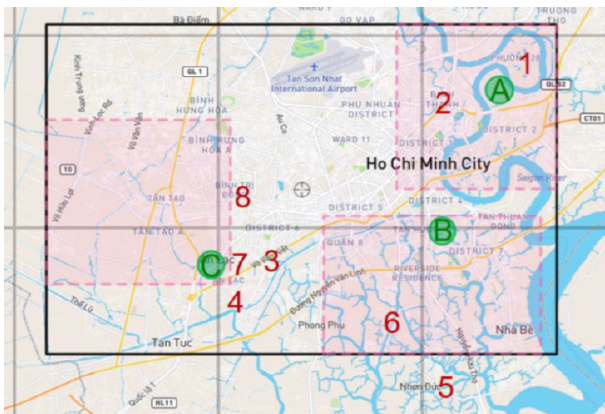
Figure 1. Survey areas ( n = 8) in Ho Chi Minh City. Red numbers are the sites of the main survey in 2020, and green letters are areas of the pre-test survey in December 2019 (Yang et al.,